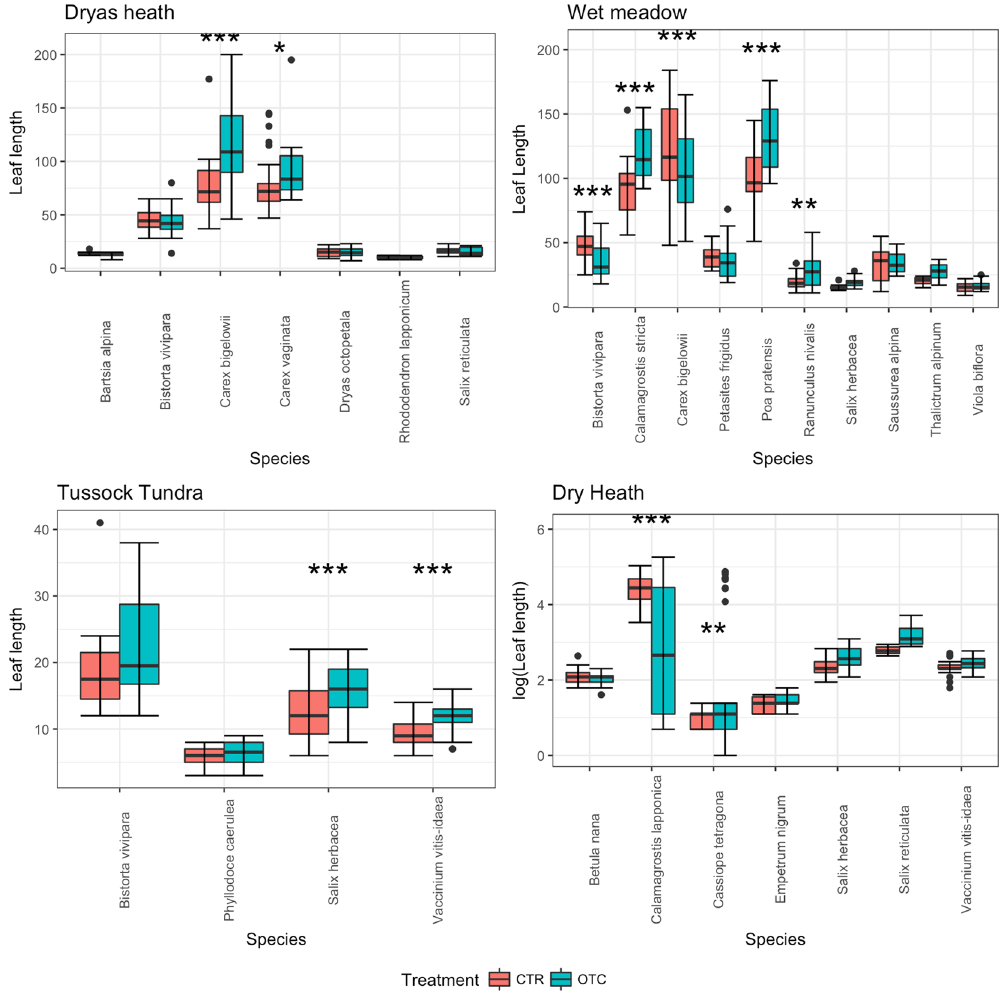
Figure 2. Leaf length (in mm) response of different plant species to 23 years of warming (open-top chamber, OTC) compared with a control treatment